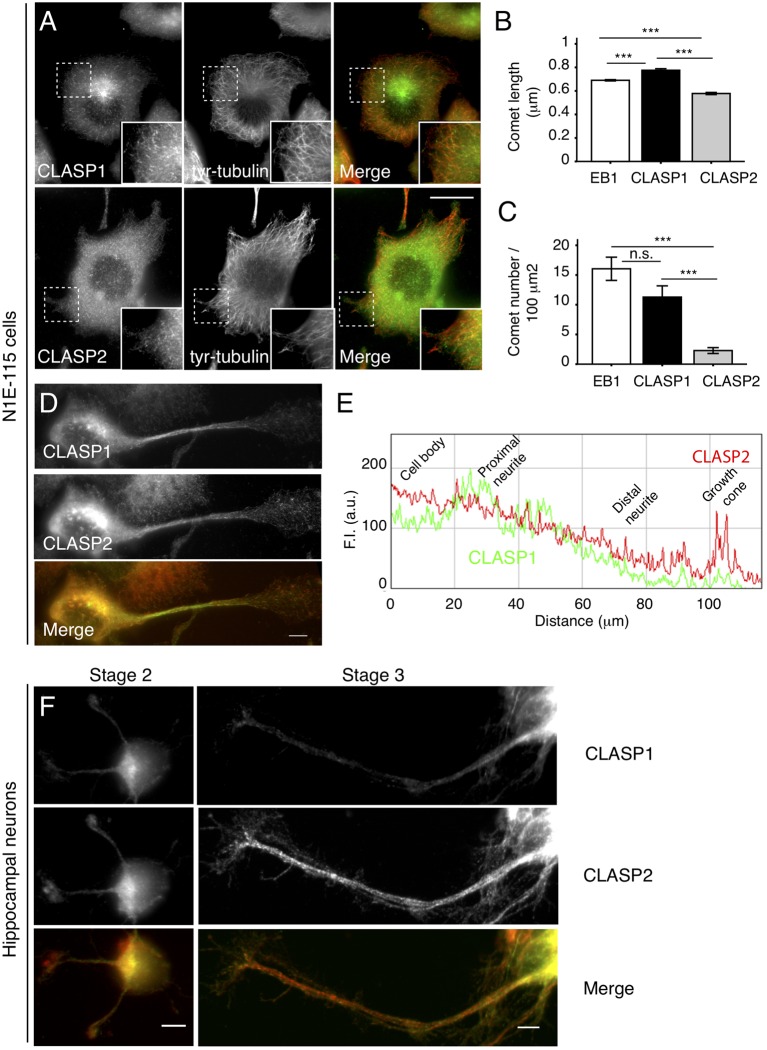
Intracellular distribution of cytoplasmic linker associated protein 1 and -2 (CLASP1 and -2) in differentiating N1E-115 cells and young primary hippocampal neurons (HNs). (A) CLASP1 and CLASP2 distribution in flattened N1E-115 cells. Fluorescence images of cells that were serum-deprived overnight, fixed and stained with antibodies against CLASP1 (upper left panel, green in the merged image) or CLASP2 (lower left panel, green in the merged image) and tyrosinated-tubulin (middle panel, red in the merged images). Scale bar = 20 μm. Insets show protein localization in more detail. (B,C) Quantification of microtubule (MT) plus-end staining (comets). Comet length (B) and density (C) of MT plus ends stained with end binding 1 (EB1), CLASP1 or CLASP2 antibodies, were measured in immunofluorescence (IF) images such as depicted in panel (A). Comets were counted in 3–4 squares of 100 μm2 per cell. EB1: n = 3566 comets/24 cells; CLASP1: n = 699 comets/19 cells; CLASP2: n = 962 comets/48 cells. ANOVA tests were performed in (B,C). Standard error of the mean (SEM) is depicted in each bar graph. (D) Localization of CLASP1 and -2 in neurite-bearing N1E-115 cells. Cells were fixed and stained with antibodies against CLASP1 (green in merge) and -2 (red in merge). In (E) a plot is shown with the fluorescence intensity (FI) distribution of CLASP1 (green) vs. CLASP2 (red) in process-bearing cells, from the cell body to the growth cone. (F) Localization of CLASP1 (green in merge) and -2 (red in merge) in mouse primary 1 days in vitro (DIV) HNs, at differentiation stages 2 and 3. Scale bars = 50 μm.